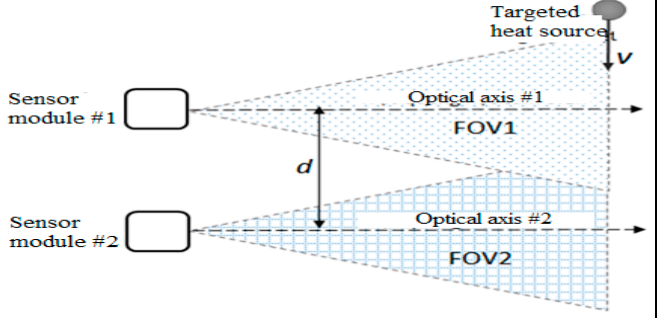
Figure 1. Description of the layout of the vehicle speed measurement system using two PIR sensor modules [10].